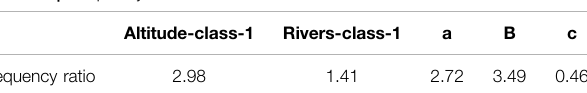
TABLE 6 | Frequency ratios of altitude-class-1 and rivers-class-1.